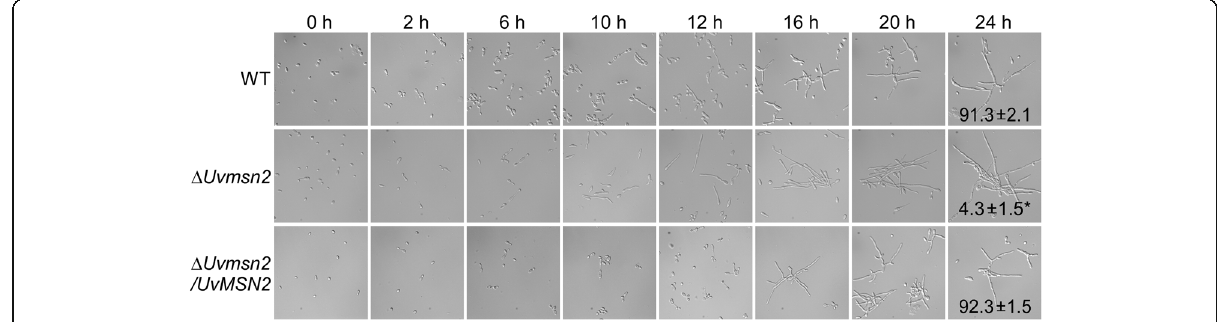
Fig. 3 UvMsn2 is important for conidial germination in Ustilaginoidea virens . Conidia of the wild-type HWD-2, Δ Uvmsn2 and Δ Uvmsn2 / UvMSN2 strains were incubated in liquid YTS medium. Examination of conidial germination under a microscopy was performed at 0, 2, 6, 10, 12, 16, 20 and 24 h after incubation. The number at the last column represents the percentage of multiple germ tubes of the indicated strains at 24 h after incubation. The mean values ±SD were calculated from three independent experiments, and asterisk indicates a statistically significant difference from the wild-type strain ( P < 0.01)